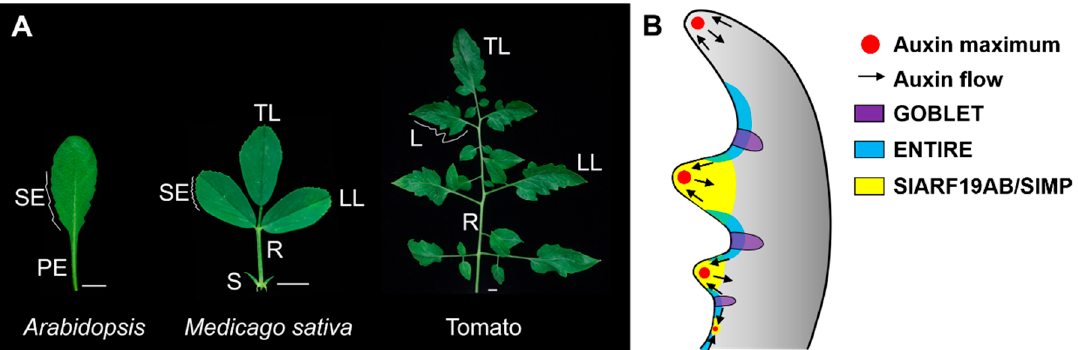
Figure 3. Morphology of simple and compound leaves. ( A ) Leaves of Arabidopsis , Alfalfa ( Medicago sativa ) and tomato. SE, serration; PE, petiole; TL, terminal leaflet; LL, lateral leaflet; R, rachis; S, stipule; L, lobe. Scale bars: 1 cm. ( B ) Model of the regulation of compound leaf development by auxin, GOB , E , and E-targeted ARFs in tomato.